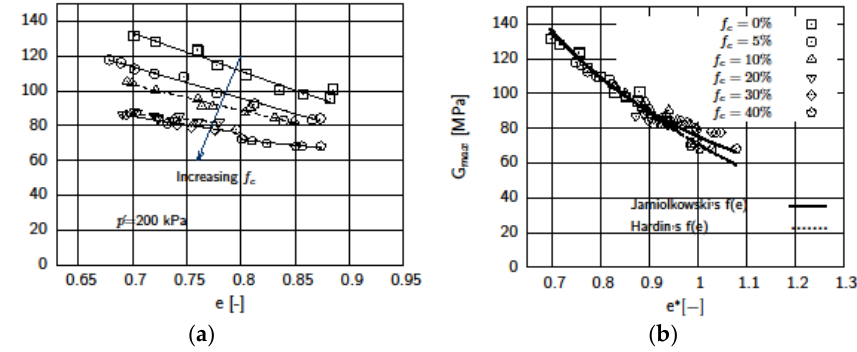
Figure 2. ( a ) Influence of fines content on the G max via RC tests; ( b ) using the concept of equivalent granular void ratio e* to capture varying percentages of fines content ([10]).